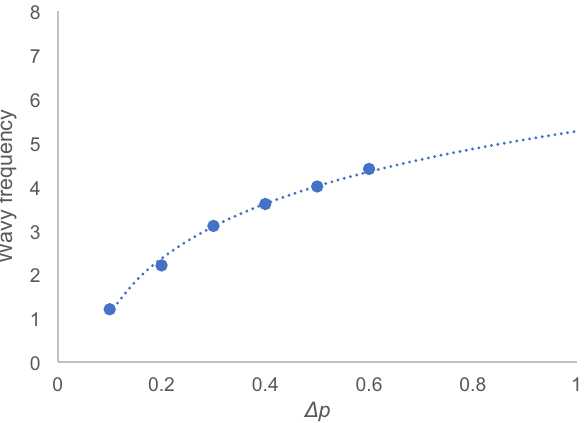
Figure 4. Plot of the mean frequency of the simulated infectious wave for Δ p . The fitting line is the result of regression analysis on the logarithmic function. The correlation coefficient was > 0.95. The vertical y-axis represents the wavy frequency given by the relative value, and the horizontal axis represents the recovery rate difference Δp = p − p c . The vertical axis represents the frequency per the time unit (30 days) in the horizontal axis in Fig.